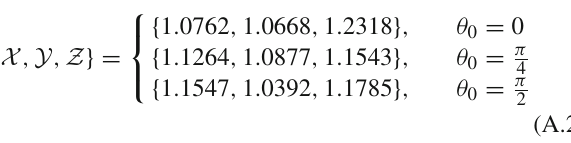
Fig. 1 Shadows of the extremal Kerr black hole of m = 1 = a , corre- right plot is the shadow viewed from θ 0 = π/ 2 and we have x − = − 2 √ = 1 and x + = 7 at r − = 4; therefore, we have R sponding to M = 1 and R + = at r − 2. The left one is the shadow viewed (cid:6) ph ph √ √ and R sh = 9 / 2. In all the three cases, we have X > 1, Y > 1 and from the north pole with r ph = 1 + 2 and hence R ph = 2 ( 2 + 2 ) +√ Z > 1,for ( X , Y , Z ) definedin(2.33).Asacomparison,forthe M = 1 and R sh = 2 ( 1 2 ) . The middle plot is viewed from angle θ 0 = π/ 4, Schwarzschild black hole, we have R + = 2, R ph = 3 and R sh = 3 = 1 . 0583 and r + = 3 . 5549, giving x − = − 2 . 824 and we have r − Thus rotation makes the black hole to appear ph ph x + = 6 . 403, and hence we have R ph = 2 . 449 and R sh = 4 . 613. The